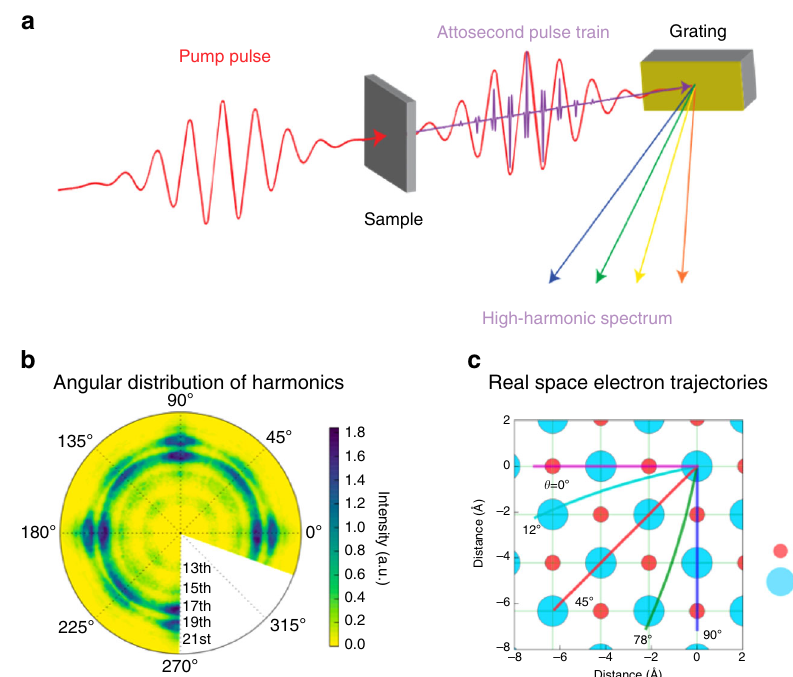
Fig. 5 High-harmonic spectroscopy of solid materials. a Schematics for HHS of solid-state materials in transmission geometry. Few-cycle laser pulses excite the sample at the V/Å level without damage. Attosecond pulses are produced on subcycle timescales, which interfere in the far fi eld and produce discrete peaks in high-harmonic spectrum. b Measured crystal orientation-dependent high-harmonic spectrum from wide-bandgap cubic MgO crystal. c Real-space electron trajectory model showing how harmonic signal increases (decreases) when the electron trajectories connect (miss) neighboring atomic sites. If trajectories connect the fi rst nearest neighbors (O – Mg), they produce the strongest signal, as seen along cubic directions. If they connect the second nearest-neighbor (O – O) secondary maxima are produced, as seen along diagonal direction of the cube. Reproduced with permission